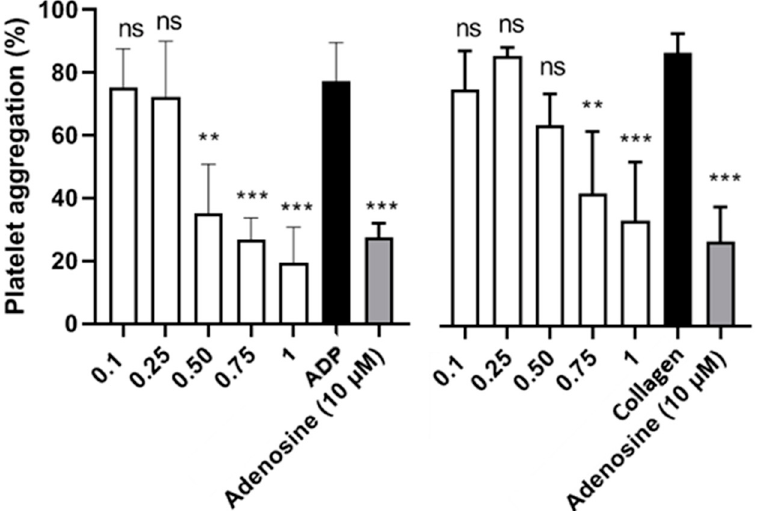
Figure 1. Study of platelet aggregation of avocado peel and seed extract induced by collagen and ADP. The PRP was previously incubated with vehicle or avocado extract (0.1, 0.25, 0.50, 0.75 and 1 mg/mL). After 3 minutes of incubation at 37 ◦ C, it was stimulated with the agonist to initiate platelet aggregation for 6 minutes. The negative control is in the absence of the extracts. Bar graph indicates maximum aggregation expressed as a percentage (mean ± SEM; n = 6). Differences between groups were analysed by ANOVA using Dunnet’s post hoc test. *** p < 0.001 and ** p < 0.01, denote statistically significant differences compared to the vehicle; ns: nonstatistical difference with respect to the vehicle (PBS).